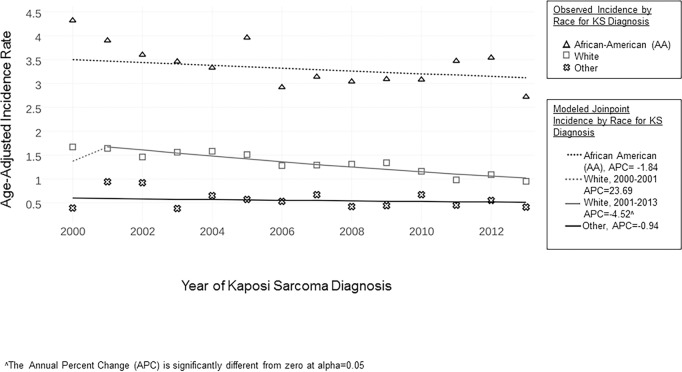
KS incidence in the U.S. by race, 2000–2013.